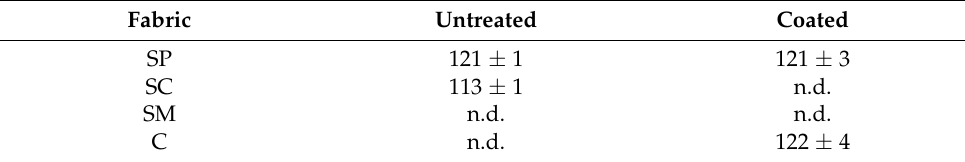
Table 4. Contact angle measurements on untreated and TACR coated fabrics.